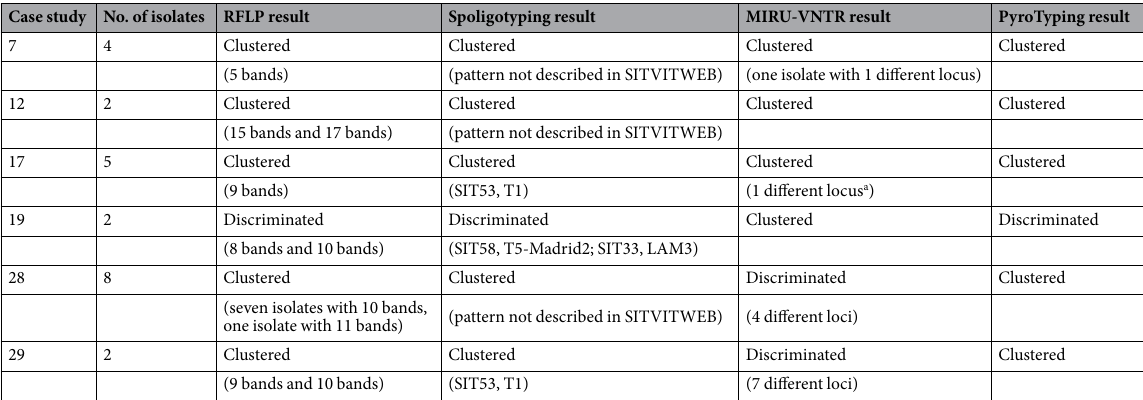
Table 2. Clustering and discrimination results of RFLP, spoligotyping, MIRU-VNTR, and PyroTyping for the isolates showing variations in the RFLP and/or the MIRU-VNTR patterns. a One isolate had 3 repeats, two isolates had 6 repeats, and two isolates had more than 15 repeats. RFLP: restriction fragment length polymorphism. MIRU-VNTR: mycobacterial interspersed repetitive units - variable number of tandem